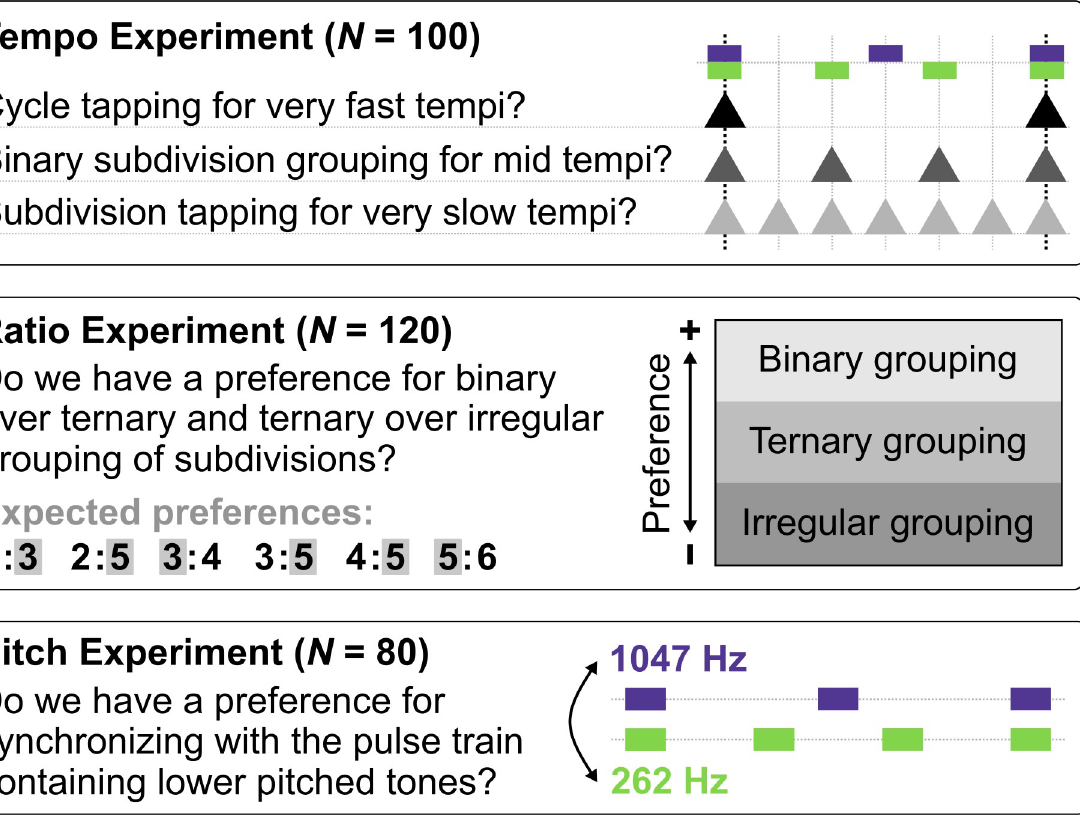
Fig 2. Experimental overview and main research questions for the three individual